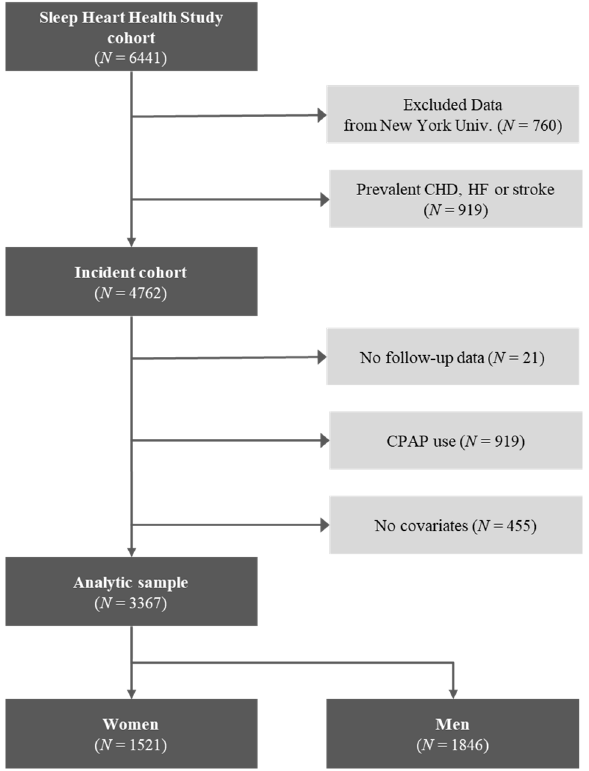
Figure 2. Ascertainment of the study sample. CPAP = continuous positive airway